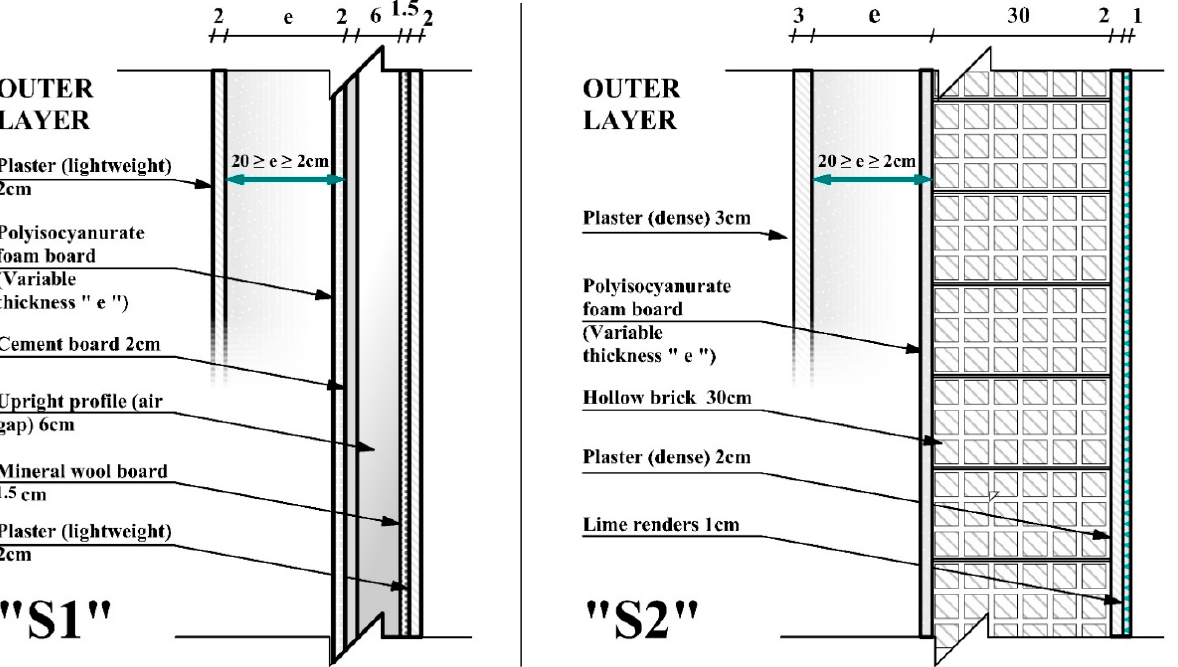
Figure 6. Building’s external wall stratifications: scenario “S1”: low mass wall; scenario “S2”: high mass wall. The outer insulation layer is presented with a variable thickness “e”.